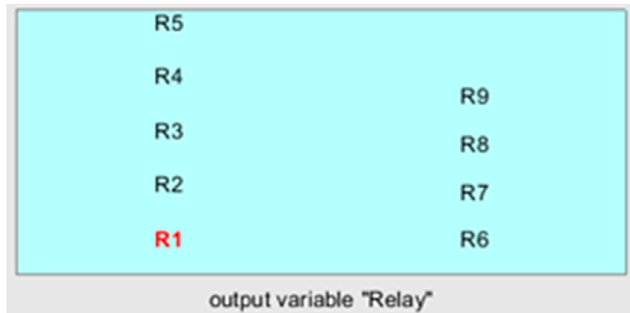
Figure 32. Output variable ‘Duty ratio’ membership functions.